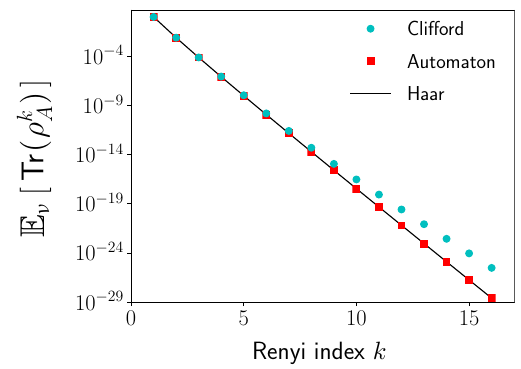
FIG. 4. The average trace of ρ k Renyi index k . We find that the expectation value E ν [Tr (ρ k over the ensemble of automaton circuits, ν , is equal to the Haar random value, E Haar [Tr (ρ k circuits, which form a unitary 3-design, E constrained to match the Haar random value up to k = 3, and show significant deviation above k ≈